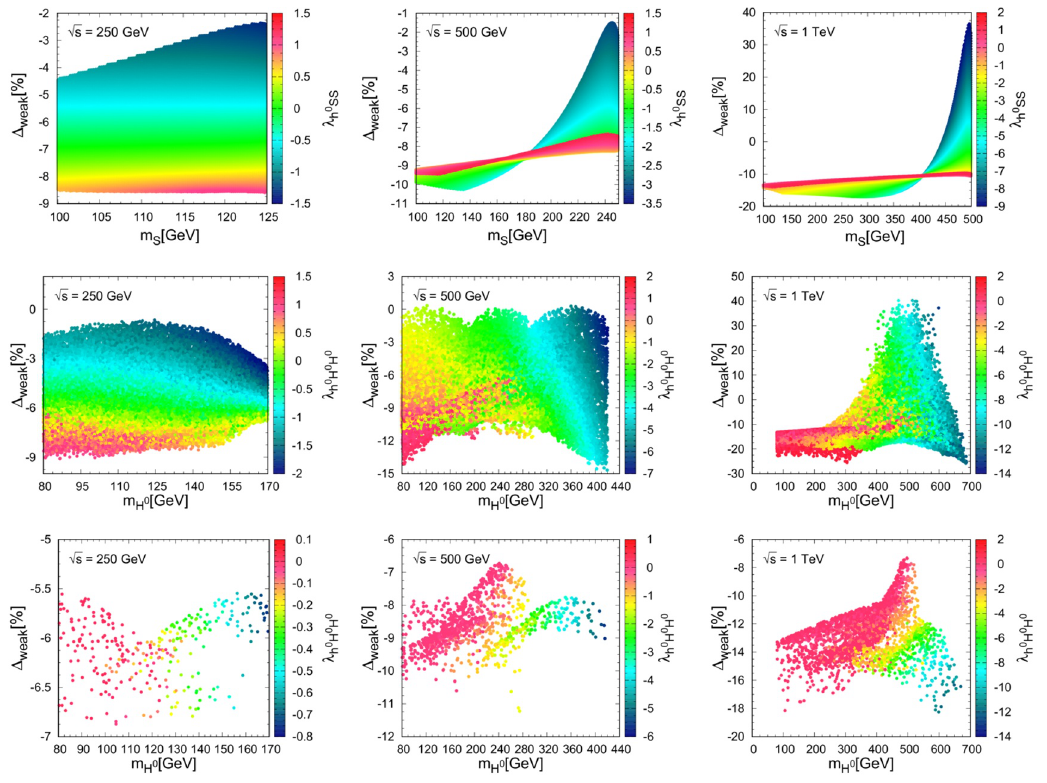
√ s = 250 , 500 , 1000 GeV.